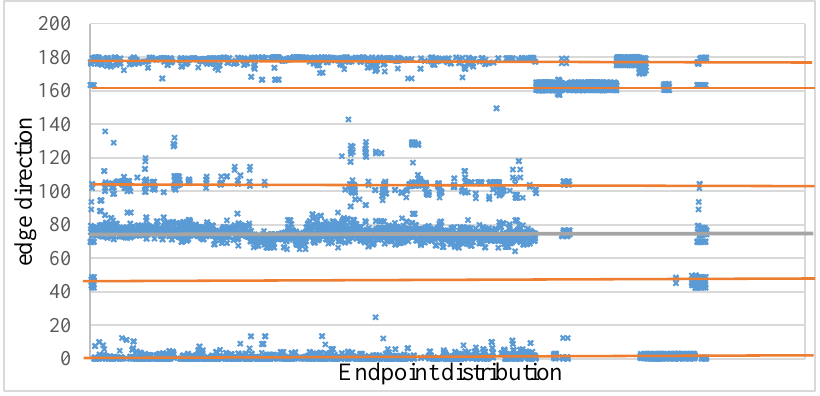
Figure 8. Directional clustering of a sample image. Six main directions are